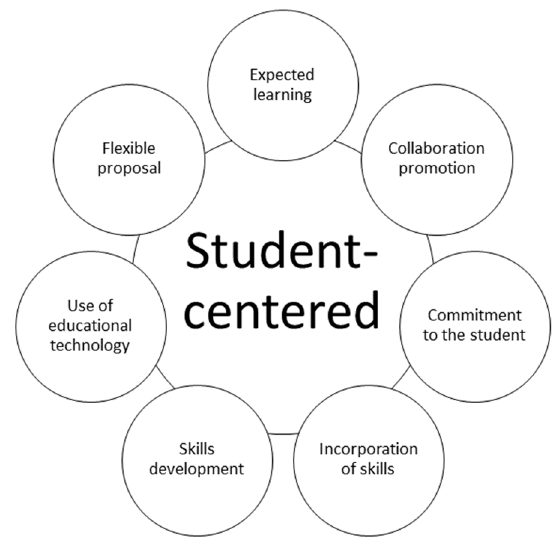
Figure 2. Online education model; student-centered learning. Online education integrates information technology (IT) with greater intensity